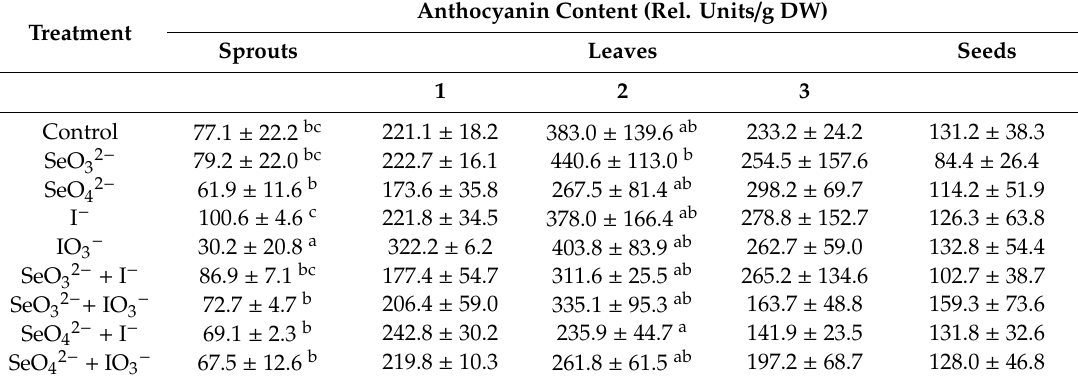
Table 3. E ff ects of the various seed and foliar treatments on the anthocyanin levels in the pumpkin sprouts, leaves of mature plants, and